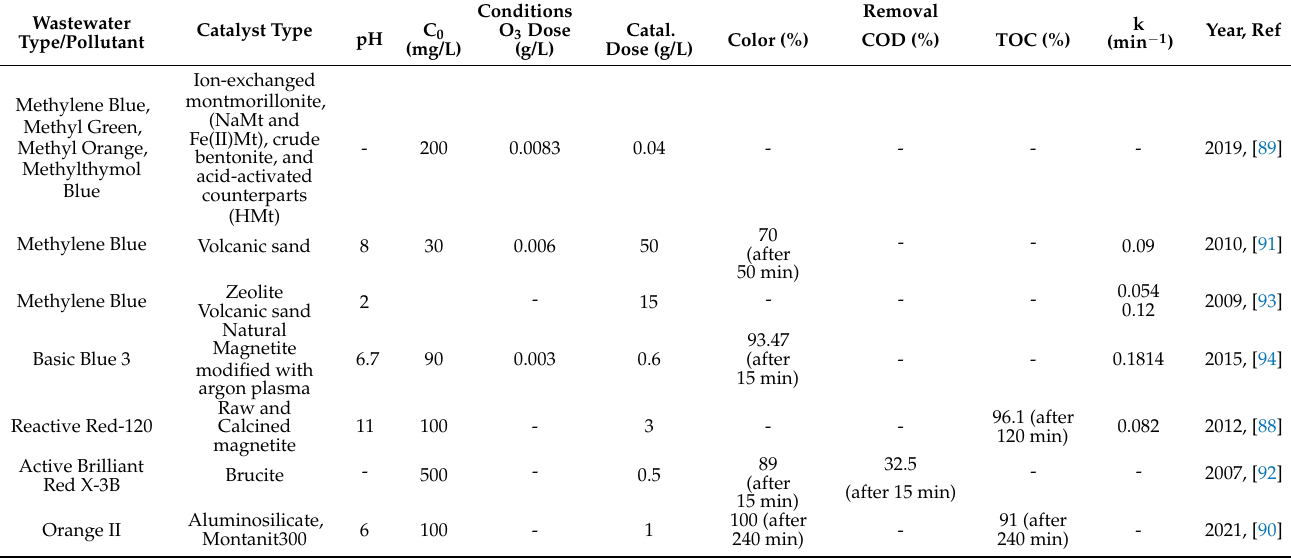
Table 5. Examples of catalytic ozonation with